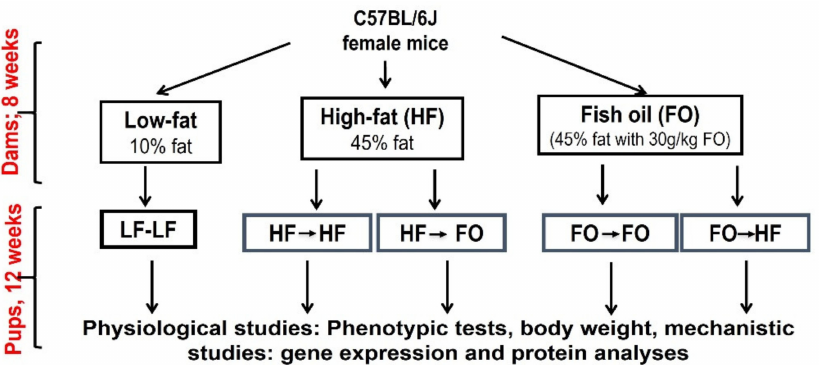
Figure 1. Study design and dietary intervention